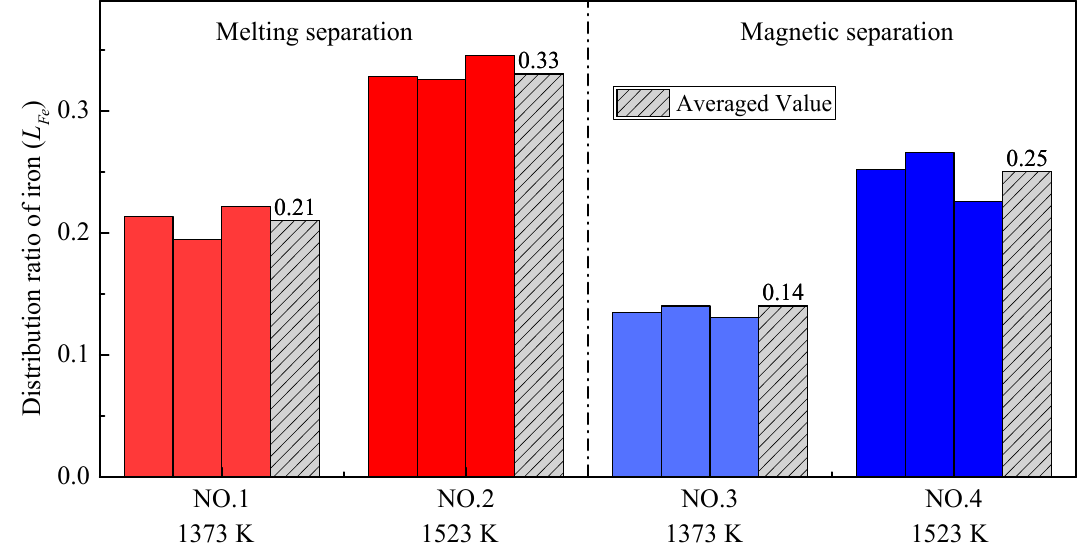
Figure 6. The distribution ratio of iron with different pre-reduction temperatures and different separation processes.